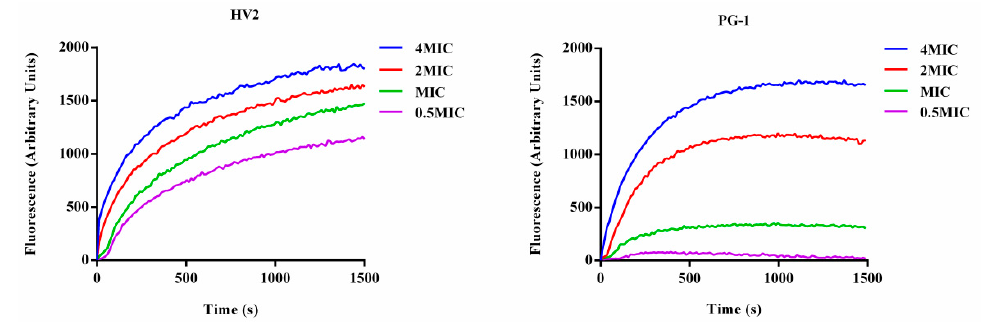
Figure 8. Cytoplasmic membrane depolarization of E. coli ATCC25922 was measured using the membrane potential-sensitive dye diSC 3 -5.